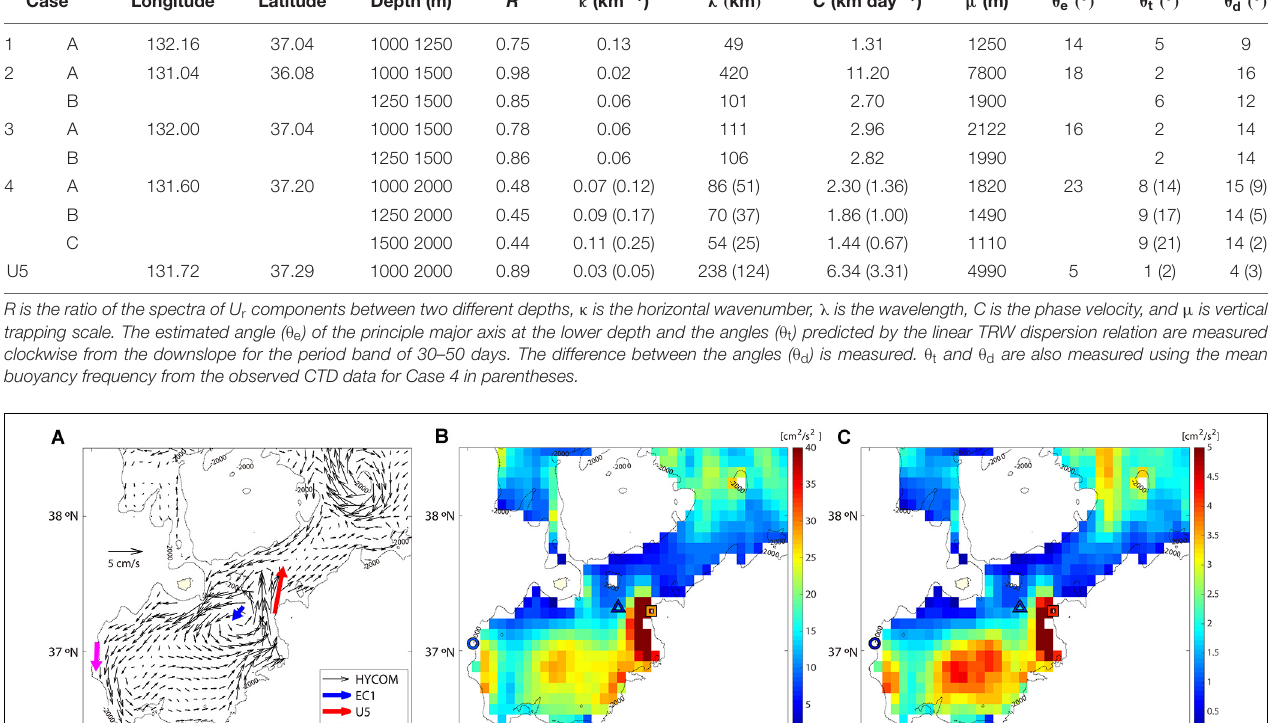
TABLE 3 | TRW parameters for eight cases and observation (U5).